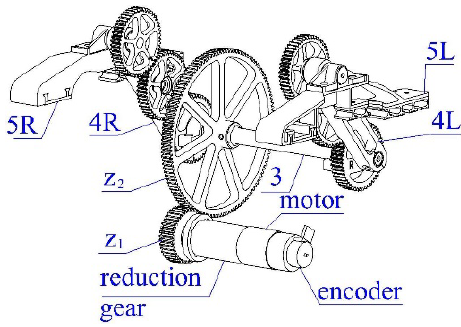
Figure 5. Walking mechanism.